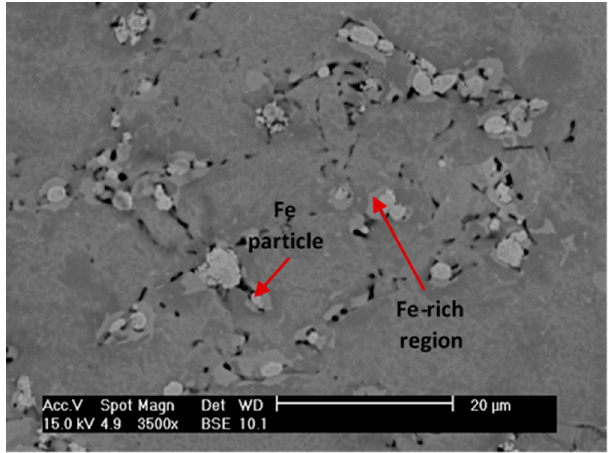
Figure 7. BSE-SEM image for TiH 2 -5Fe heated up to 650 °C: Detail of Fe diffusion .